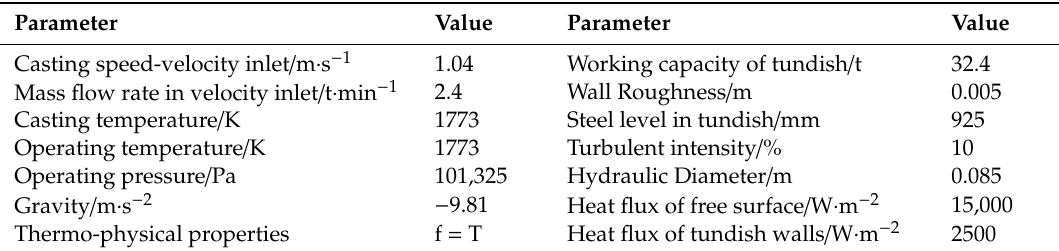
Table 1. Boundary conditions of model setting.